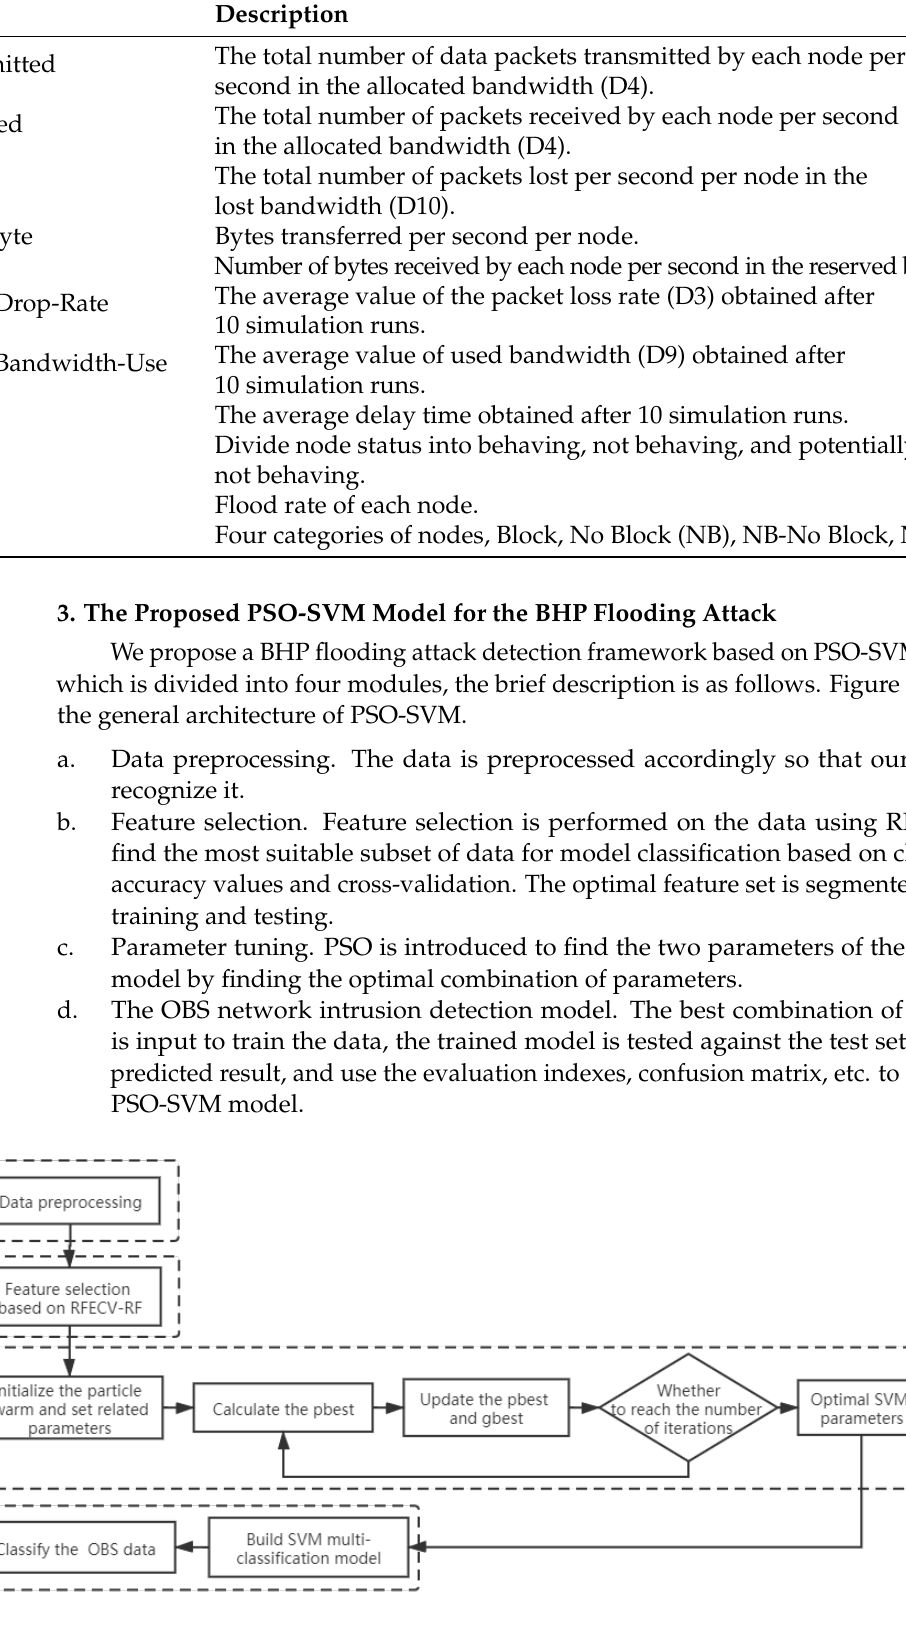
Figure 2. Architecture of the proposed PSO-SVM